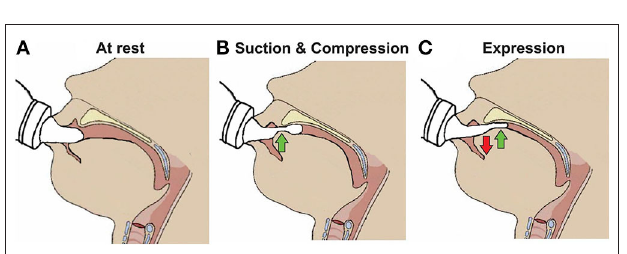
FIGURE 3 | Skills required for sucking in infants. (A) Infant at rest with the nipple inside the mouth. (B) Suction applied to the nipple to draw further into the mouth to form a teat and the tip of the tongue beginning to compress it. (C) Expression of the teat by the tongue movement against the hard palate.